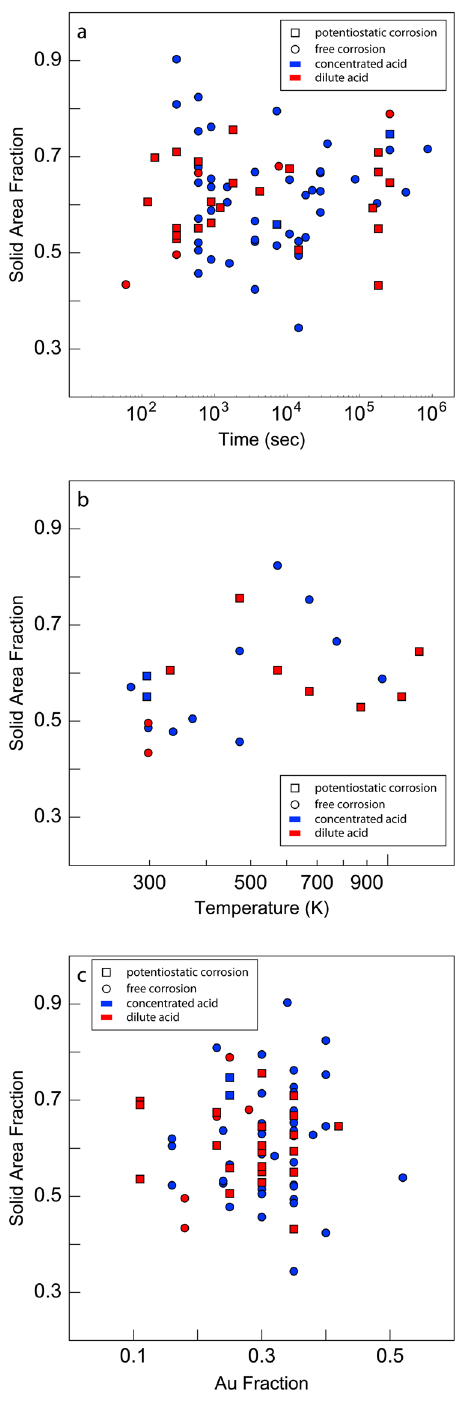
Figure 4. Lack of correlation between NPG area fraction and NPG processing parameters. ( a ) Coarsening duration at room temperature, ( b ) coarsening temperature for short durations (600–1200 seconds), and ( c ) gold fraction in the parent